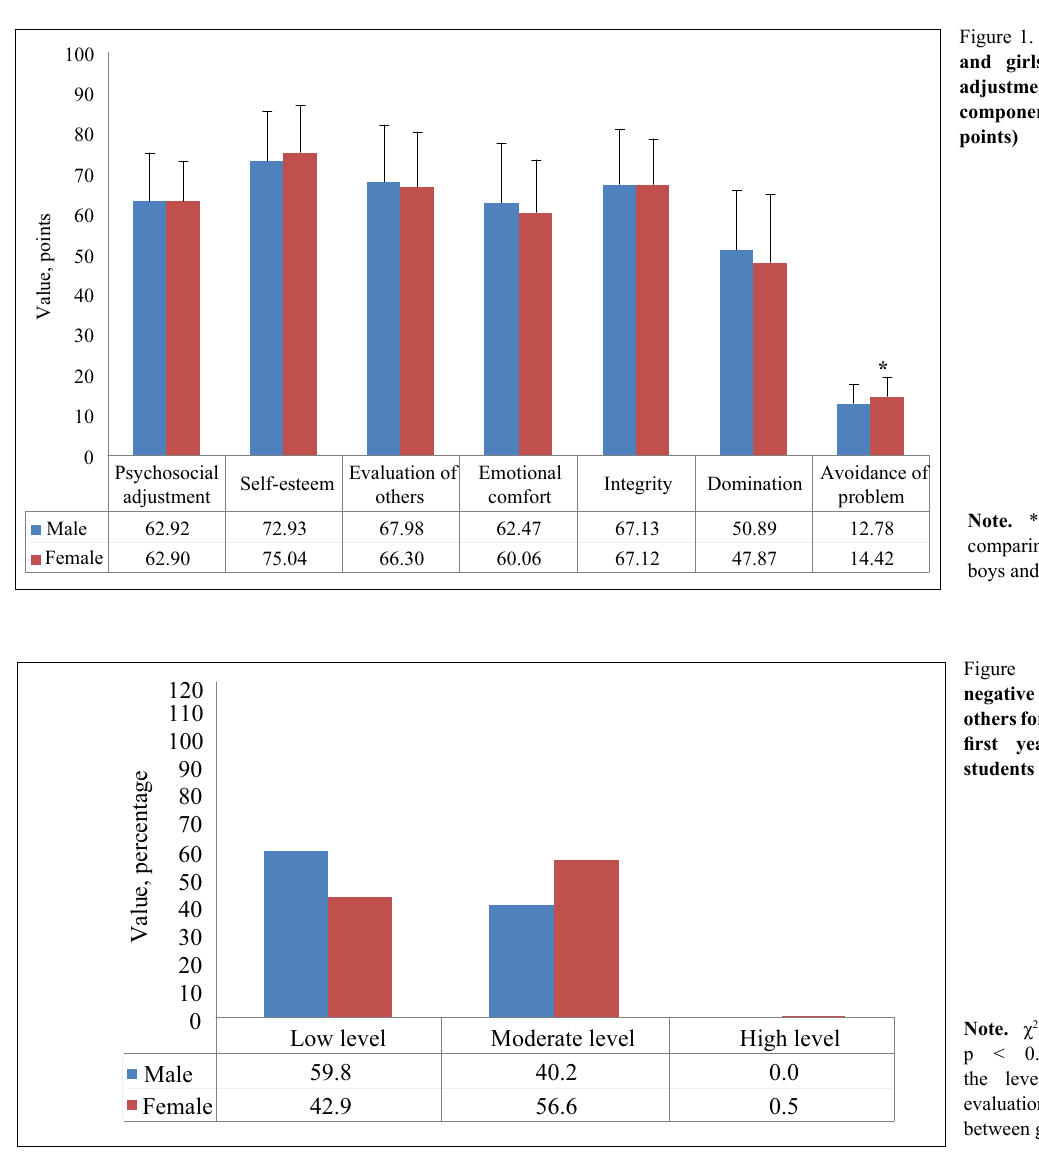
Figure 3. Levels of emotional discomfort for boys and girls, first year gymnasium students